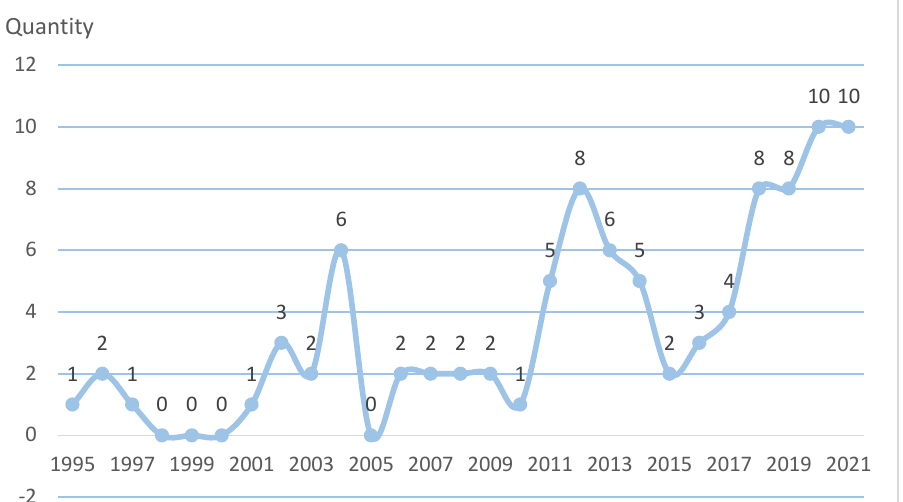
Figure 4. Map of mainstream journals in the field of rural institutional elder care.